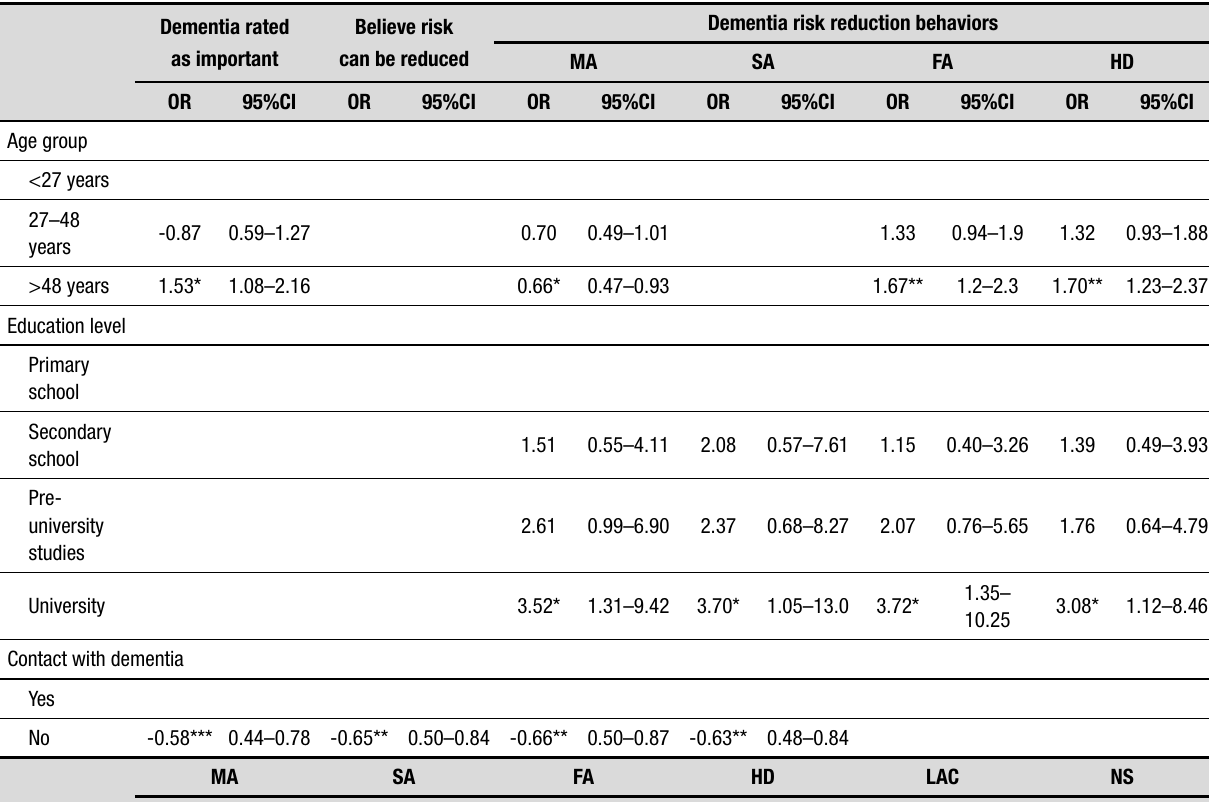
Table 4. Demographic and social factors associated with dementia risk reduction beliefs and knowledge and dementia risk reduction behaviors incorporated in participants’